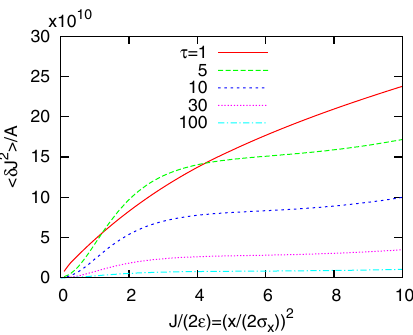
FIG. 17. Diffusion rate given by Eq. (31) for ν ¼ 0 . 31 . The rate is normalized by A ¼ ð N p r p Δ x= γσ r Þ 2 = 8